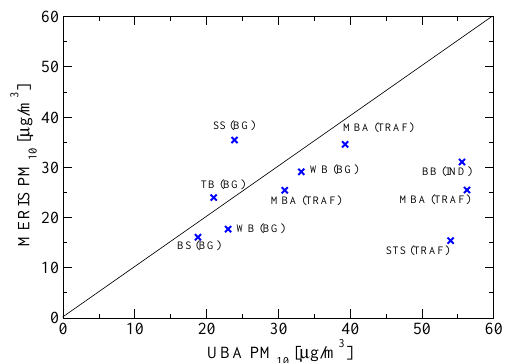
Fig. A7. Effects on the derivation of aerosol mass due to adjust- ment of different PM 10 definitions; volume integral is equivalent to Fig. 9. Comparison of ˚Angstr¨om- α coefficient at 440 and 675nm Fig. A9. Comparison of ˚Angstr¨om- α coefficient at 440 and 675nm aerosol mass). from M ERIS P MBAER and from A ERONET L2 in Hamburg. Fig. A8. Change of particle size with humidity as derived by H¨anel from M ERIS P MBAER and from A ERONET L2 in Hamburg. (1976), and measurements over Paris (see Randriamiarisoa et al. (2006) during times of increasing and decreasing humidity). For the PM 10 retrieval, the parameterization as indicated by the solid red line, is used.